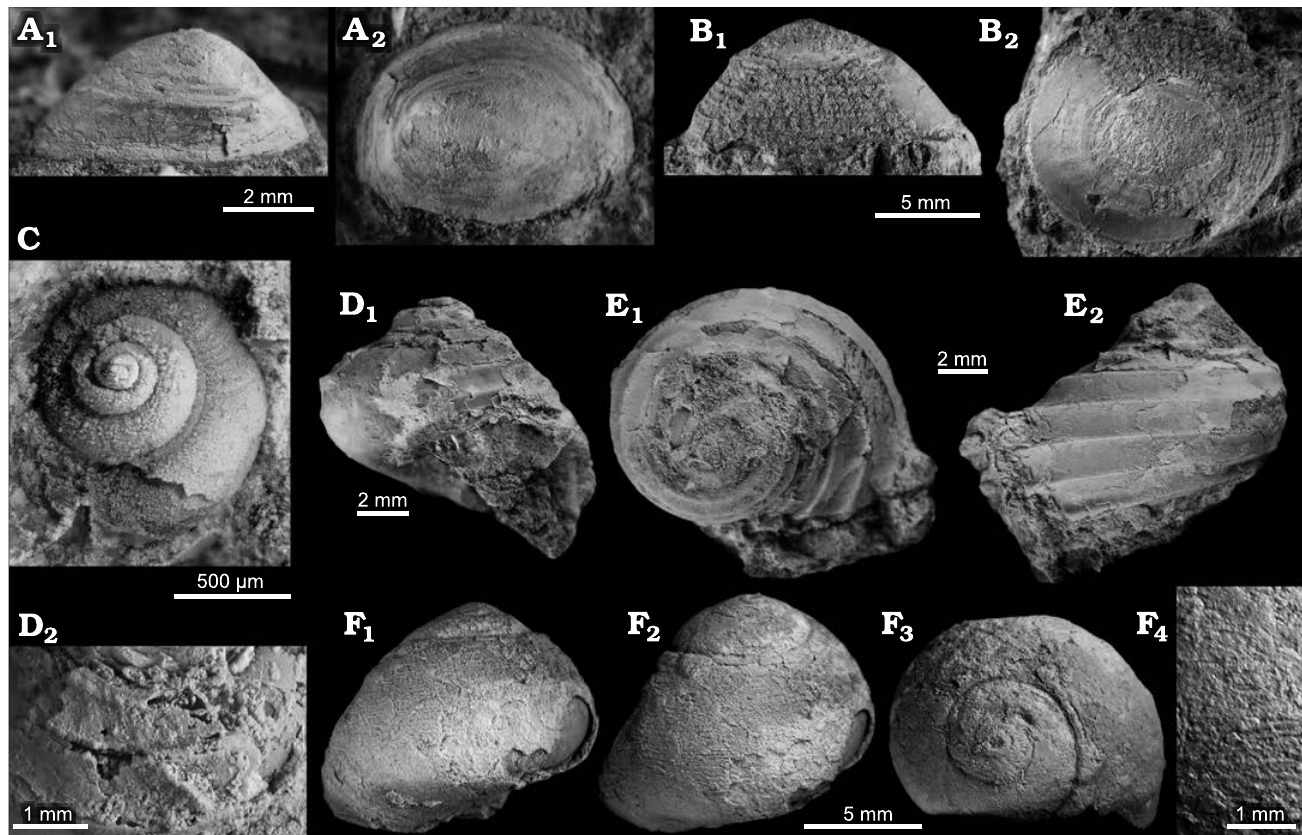
Fig. 18. Limpets, neomphalids, and vetigastropods from Upper Miocene seep deposits of the Amlang Formation in Pangasinan province, Luzon, Philippines. A , B . Unidentified limpet gastropod. A . NRM Mo 192715, small specimen, mostly an internal mold. B . NRM Mo 192656, large specimen with sculpture. C . The neomphalin Retiskenea sp., NRM Mo 192540, apical view on specimen embedded in rock matrix. D , E . The seguenzoid Cataegis sp. D . NRM Mo 192666; note sculpture on D 2 . E . NRM Mo 192665, specimen showing the strong spiral ribs, in apical (E 1 ) and abapertual (E 2 ) views. F . The colloniid Homalopoma sp., NRM Mo 192583, views on entire shell (F 1 –F 3 ) and close-up on spiral sculpture (F 4